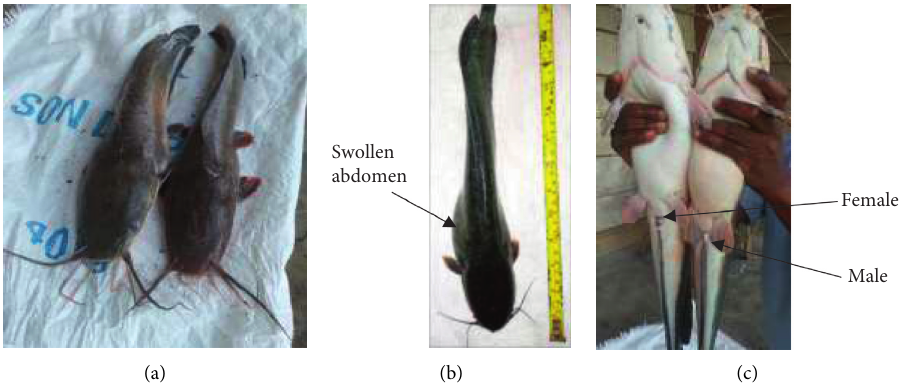
Figure 1: Broodstock of Clariidae used: (a) C. gariepinus male (to the left) and female (to the right), (b) female C. jaensis , and (c) genital papilla of male and female in